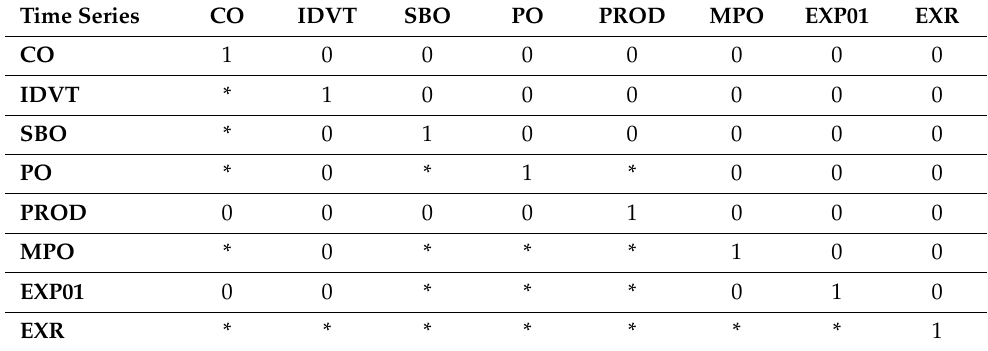
Table 5. The restrictions based on Zaidi et al. (2021) [4], with author − imposed restrictions on